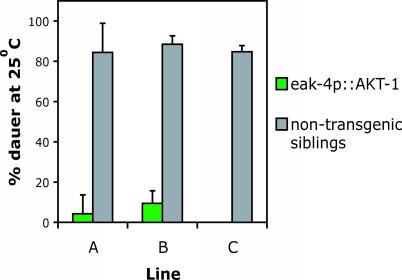
Expression of AKT-1 in XXX is Sufficient to Rescue the 25 °C Dauer Phenotype of an eak-4;akt-1 Double Mutant
eak-4(mg326);akt-1(mg306) double mutant animals carry a transgene containing the akt-1 genomic region and 3' untranslated region under the control of the eak-4 promoter. Three independent lines rescue eak-4(mg326);akt-1(mg306) dauer arrest at 25 °C. Error bars indicate standard deviation. This experiment was performed twice. Refer to Table S1 for numbers of animals scored.